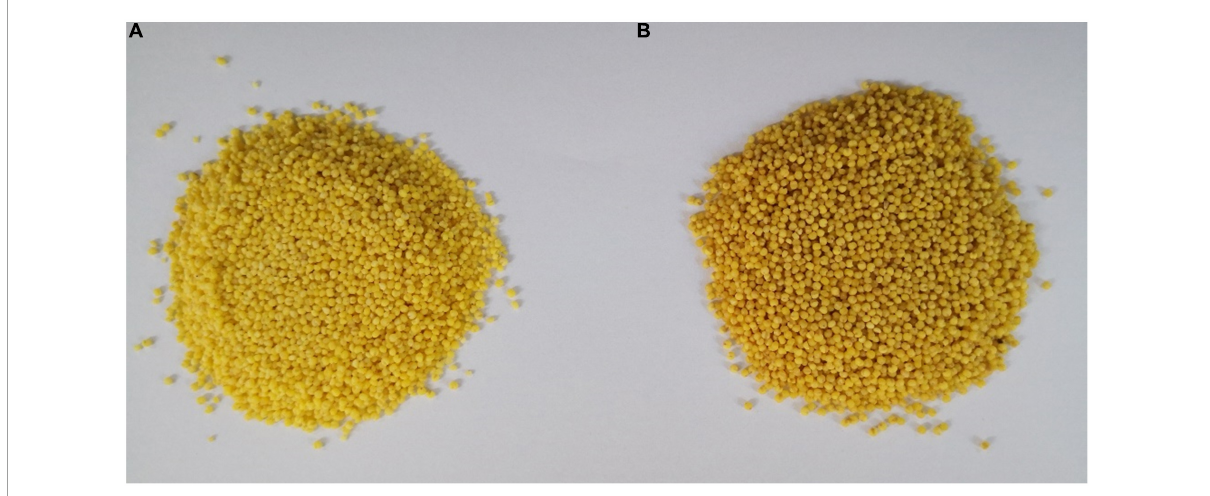
FIGURE1 The appearance of foxtail millet. (A) Mizhi. (B)